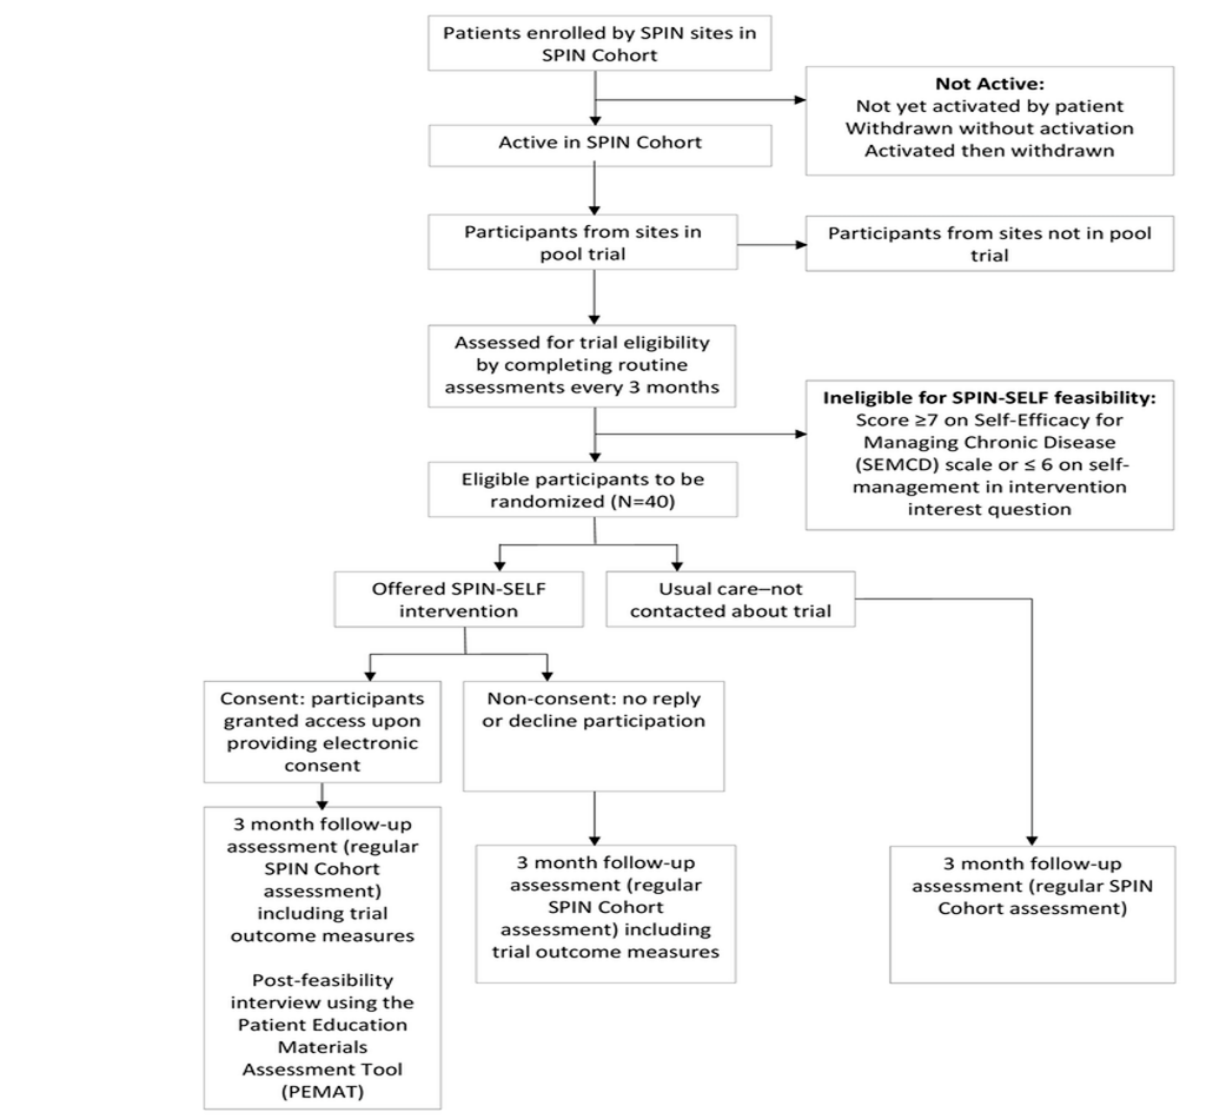
Figure 1. Scleroderma Patient-centered Intervention Network Cohort and feasibility trial flow